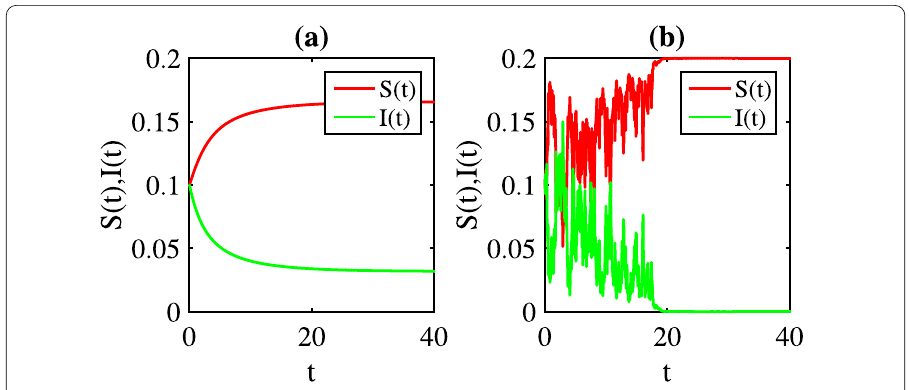
Figure 1 Time sequence diagram: ( a ) the deterministic epidemic model, ( b ) the stochastic epidemic system (7) for case (i) of Theorem 2.1